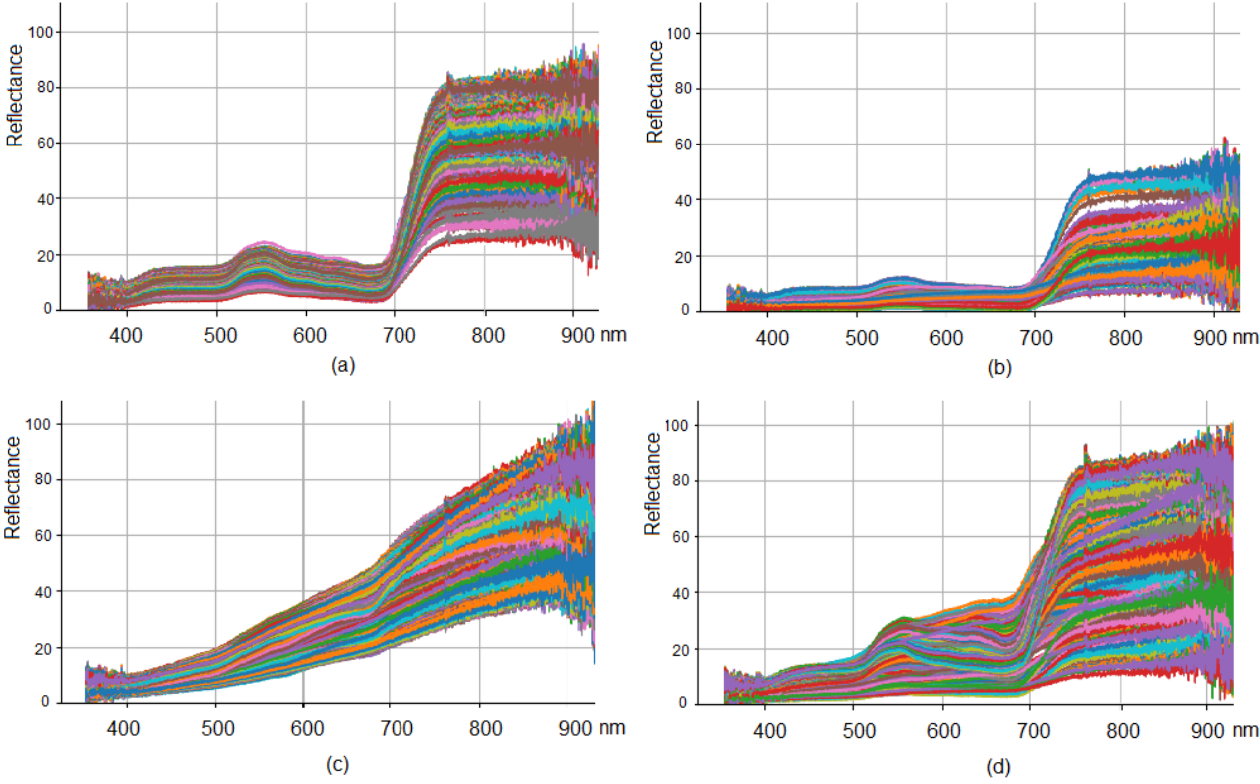
Figure 4. Two examples of curve dataset clusterization: ( a ) cluster of typical curves of healthy leaves; ( b ) cluster of invalid curves of healthy leaves; ( c ) cluster of typical curves of leaves with severe lesions caused by Septoria; ( d ) cluster of non-typical (invalid) curves of leaves with severe lesions caused by Septoria.